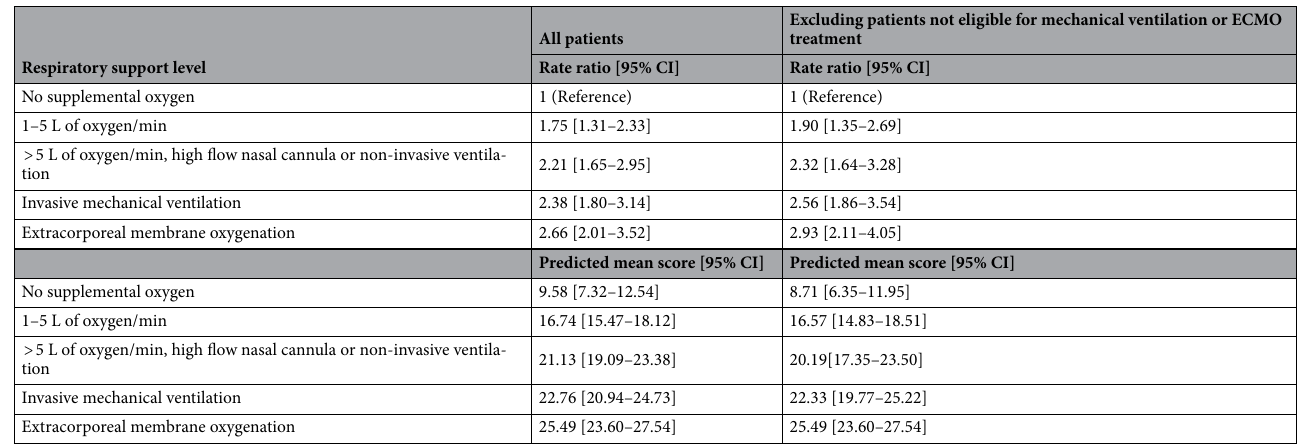
Table 3. Rate ratios and predicted MBrixia